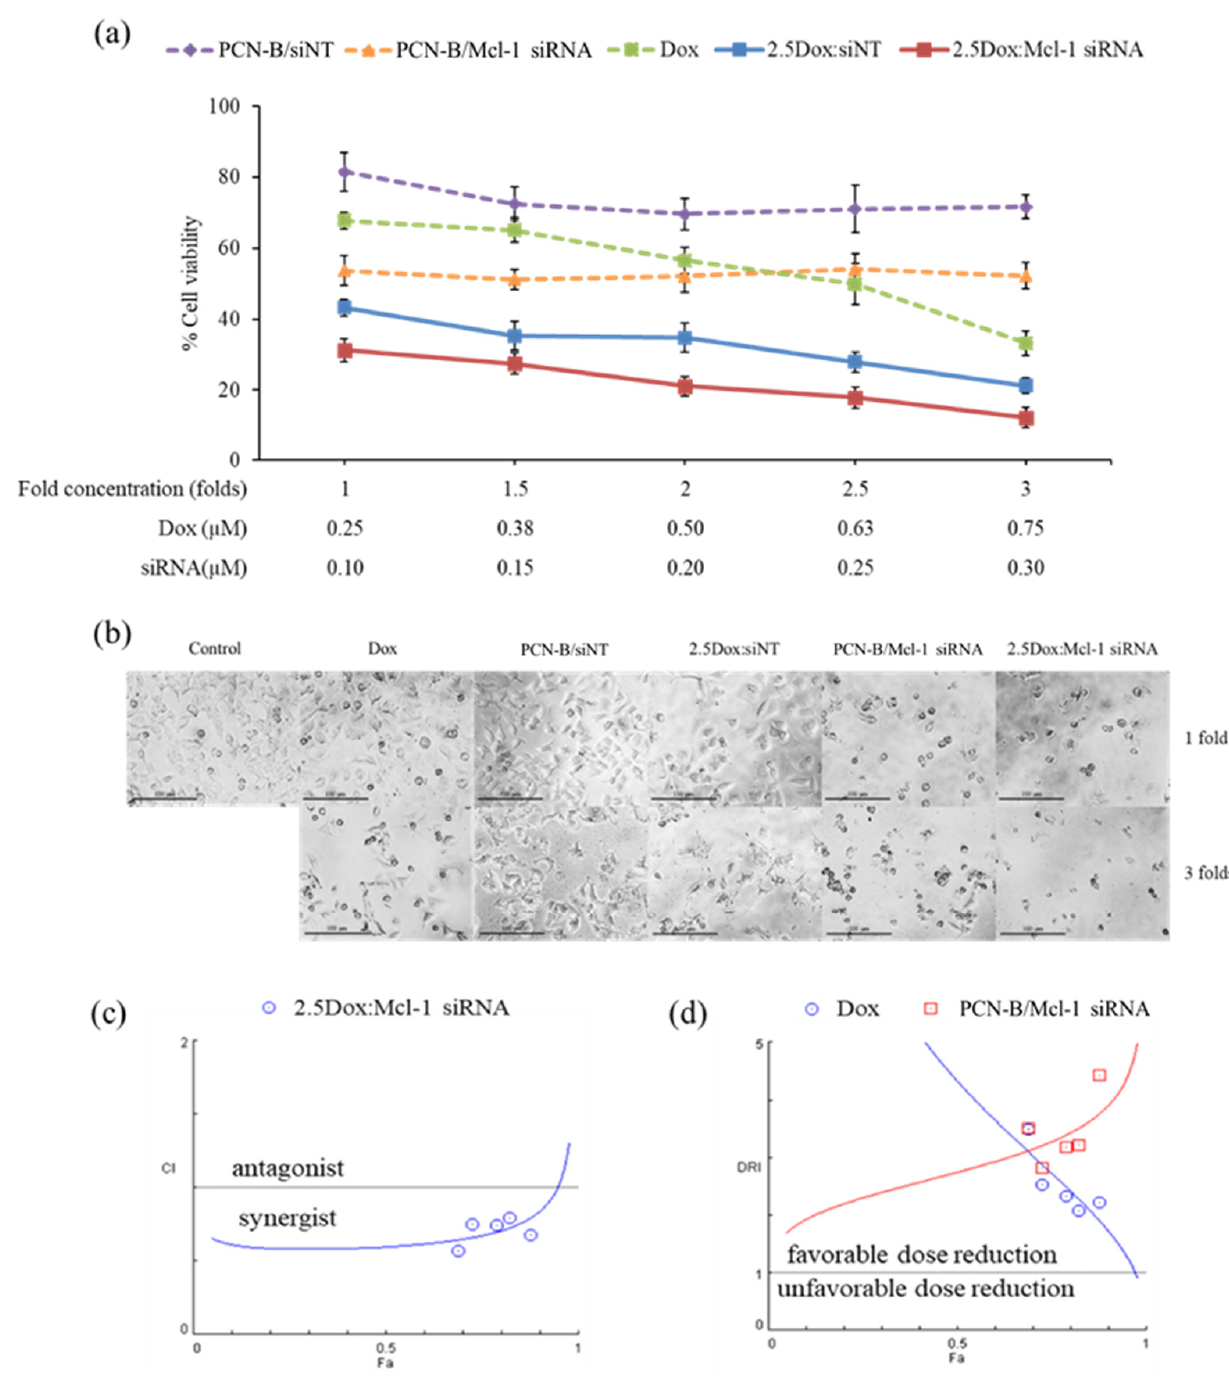
Figure 6. The constant ratio experiment was performed with Dox:Mcl-1 siRNA at the ratio of 2.5. The Dox and Mcl-1 siRNA concentration was simultaneously increased from 1- to 3-fold, starting with 0.25 µ M of Dox and 0.1 µ M of Mcl-1 siRNA. ( a ) The cell viability of MCF-7 cells treated with combination treatment and individual treatments were illustrated as solid lines and dash lines, respectively. ( b ) Morphology images after 72 h of treatments under an inverted fluorescence microscope (100X). The simulated lines were generated from CompuSyn, plotted as ( c ) CI-Fa and ( d ) DRI-Fa. The actual points were shown as circles and squares.